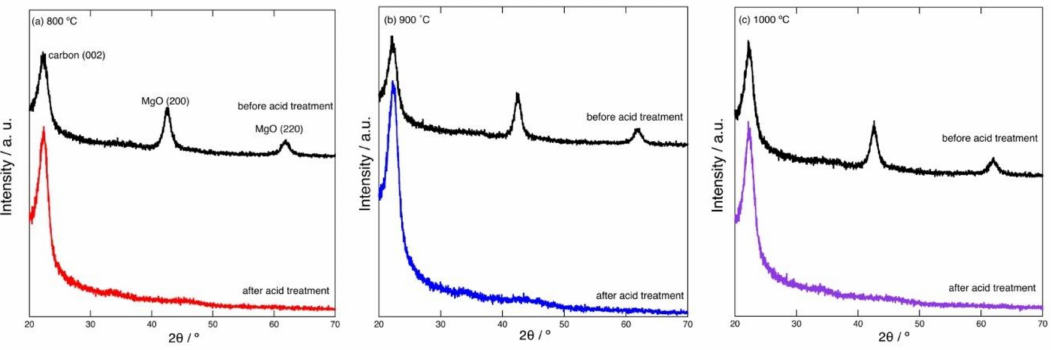
Figure 1. XRD patterns of the carbonized products prepared by heating at ( a ) 800 ◦ C, ( b ) 900 ◦ C, and ( c ) 1000 ◦ C: Before sulfuric acid treatment (black) and after sulfuric acid treatment (red, blue, and purple).